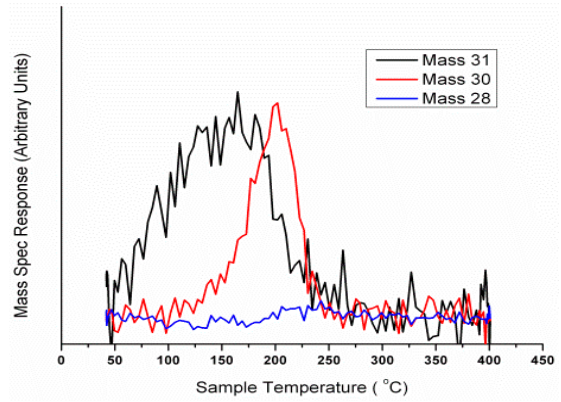
Figure 1. TPD profile for MeOH adsorbed onto the surface of MoO3 For these experiments, MeOH was adsorbed onto the surface of the catalyst, through injection into a flow of He over the catalyst. MeOH was adsorbed to saturation, after which the catalyst was ramped to 400 °C under He, whilst monitoring the products of desorption through mass spectrometry.